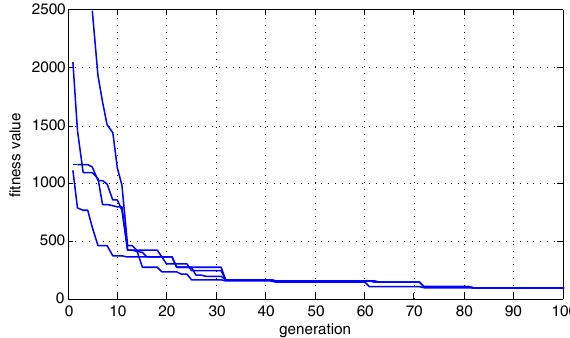
Figure 1. Sample optimization tasks. The LDPC code (128,72) has been selected for the optimization. The convergence of the best fitness value (the best value in the population produced in the particular generation) to the optimal solution can be seen.